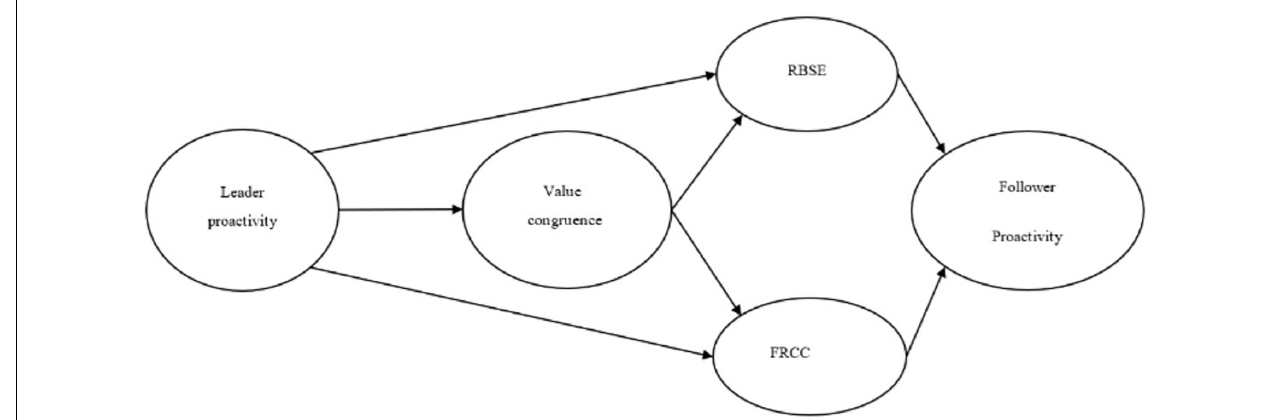
FIGURE 1 | Conceptual